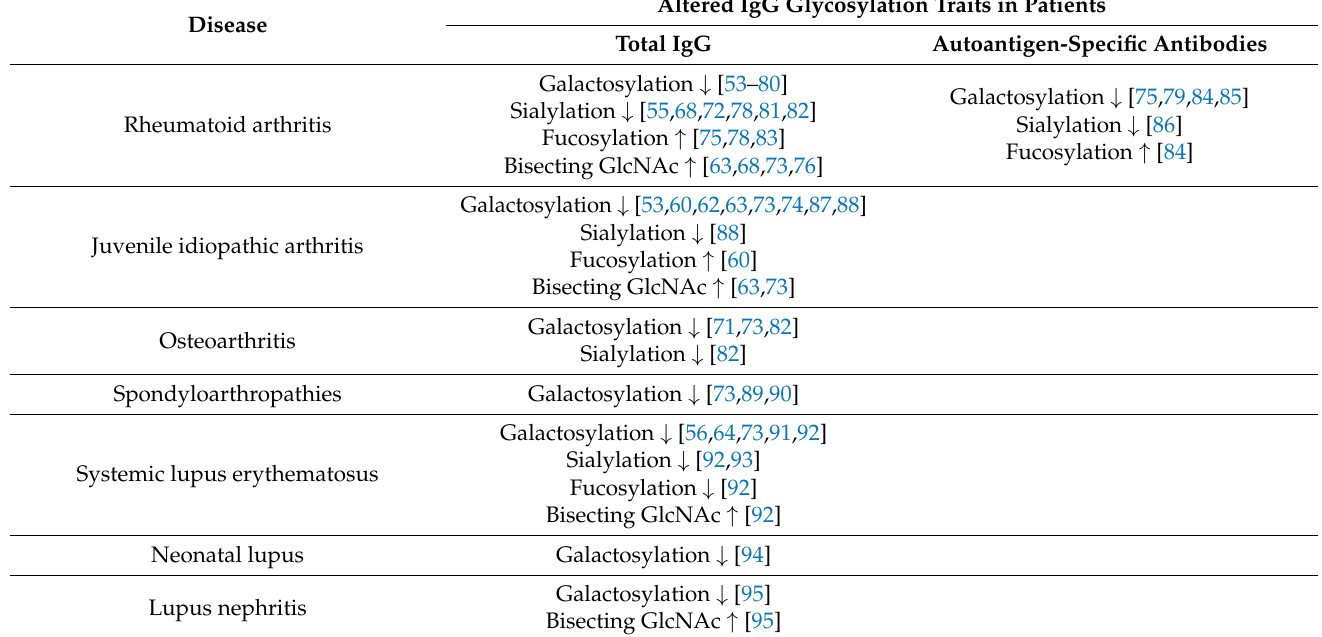
Table 1. Comparative serum IgG N-linked glycosylation studies between healthy individuals and patients with autoimmune